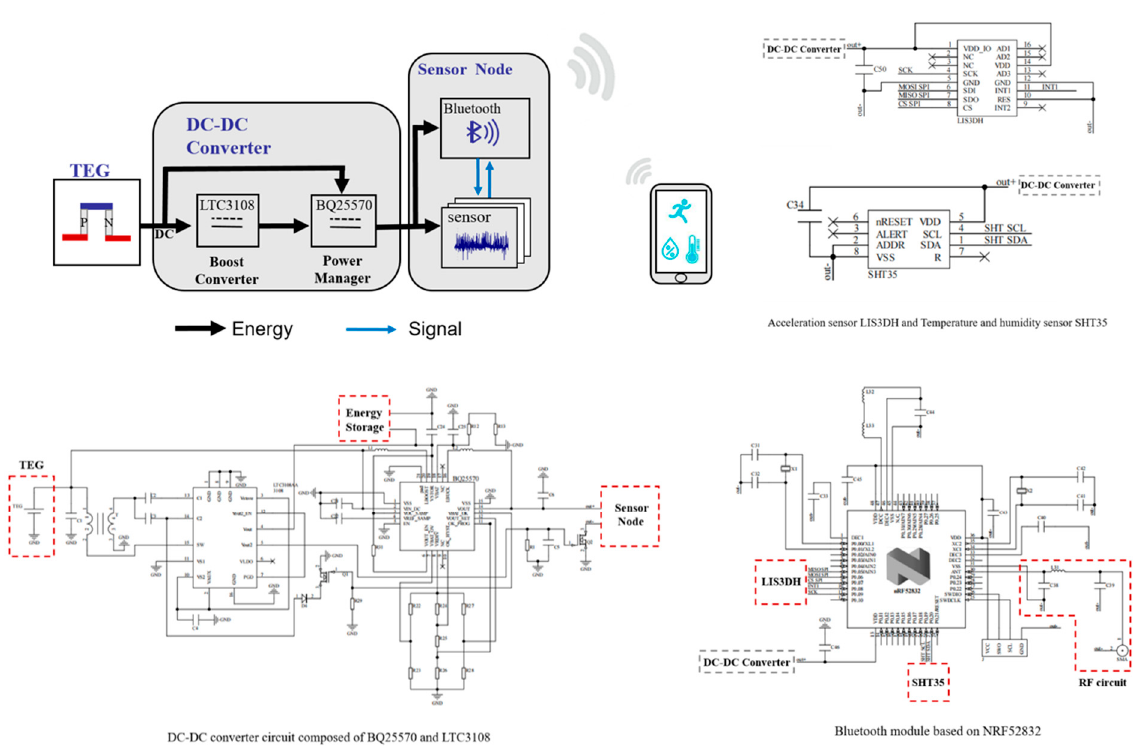
Figure A1. The electric circuit of the energy management and sensors.